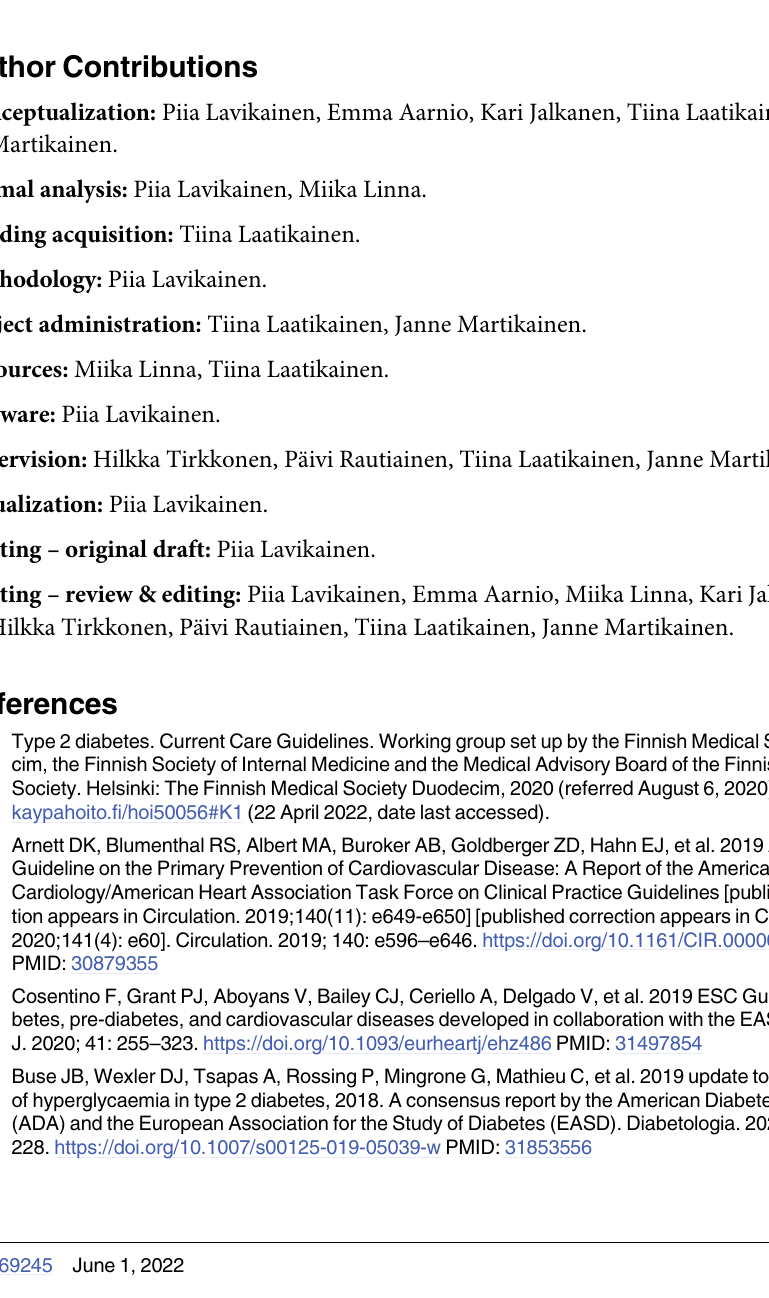
S3 Table. Unadjusted latent class growth analyses for HbA1c values measured annually since T2D diagnosis among patients diagnosed in 2011 or 2012 (n = 1540). S4 Table. Antidiabetic medication use (%) by the trajectories after the T2D diagnosis. S5 Table. Associations between the estimated HbA1c trajectories and incidence of deaths and diabetes complications. S6 Table. Average accumulated 4-year per-person healthcare costs (euros, € ) by HbA1c trajectories in 2014–2017. All the costs are adjusted for censoring due to death utilizing Kaplan-Meier sample average